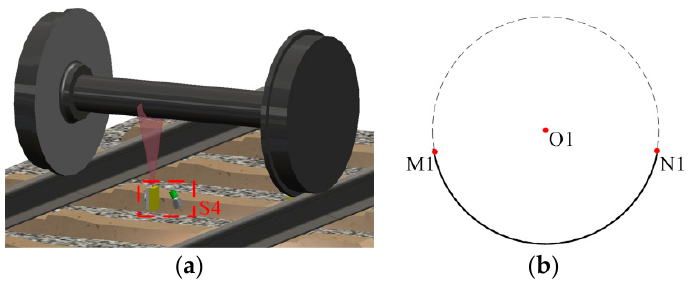
Figure 9. The wheelset axle measurement. ( a ) The sensor for the axle; ( b ) the result of S4.